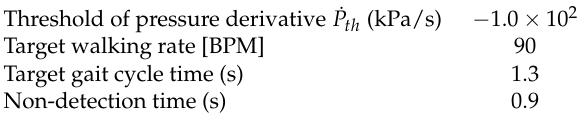
Table 3. Given parameters for the conventional control method.